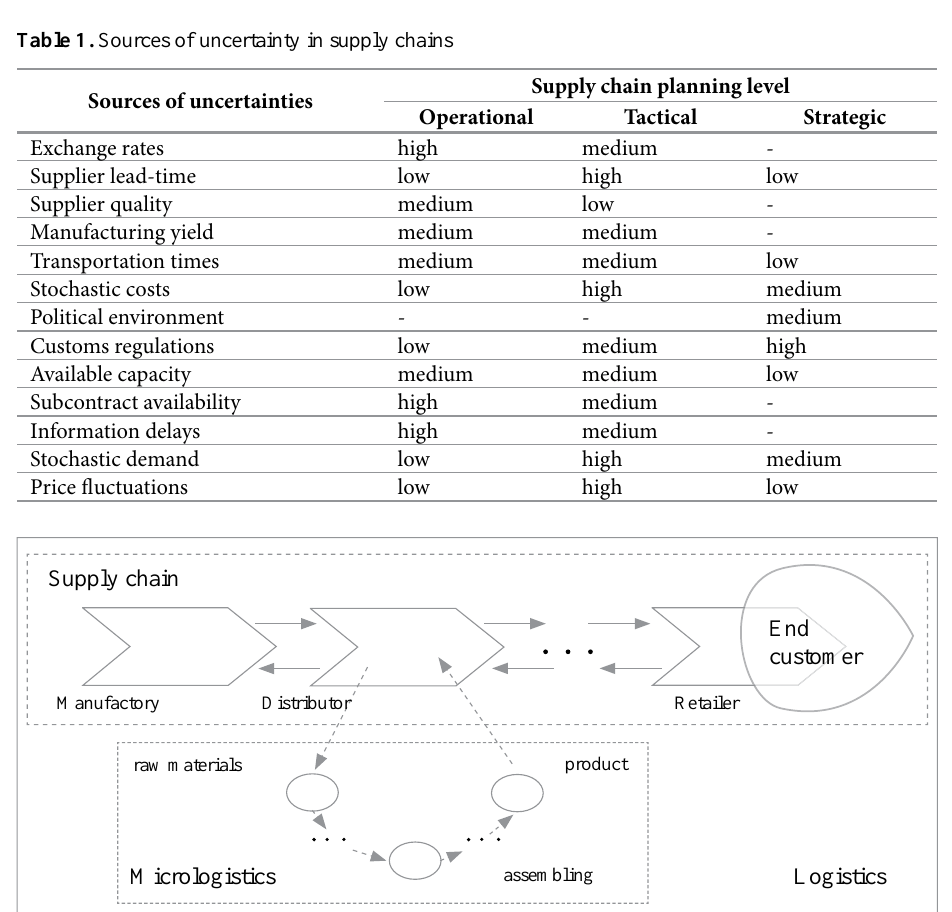
Fig. 3. Supply chain as part of logistics